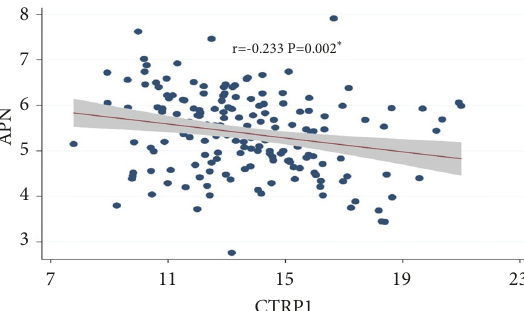
Figure 4: Scatter diagram of correlation between CTRP1 and APN. Note: CTRP1 (r value was -0.233) was significantly negatively correlated with APN ( ∗ P < 0.05) in the hypertension group 1 and the “shade” represents 95%CI of fitted